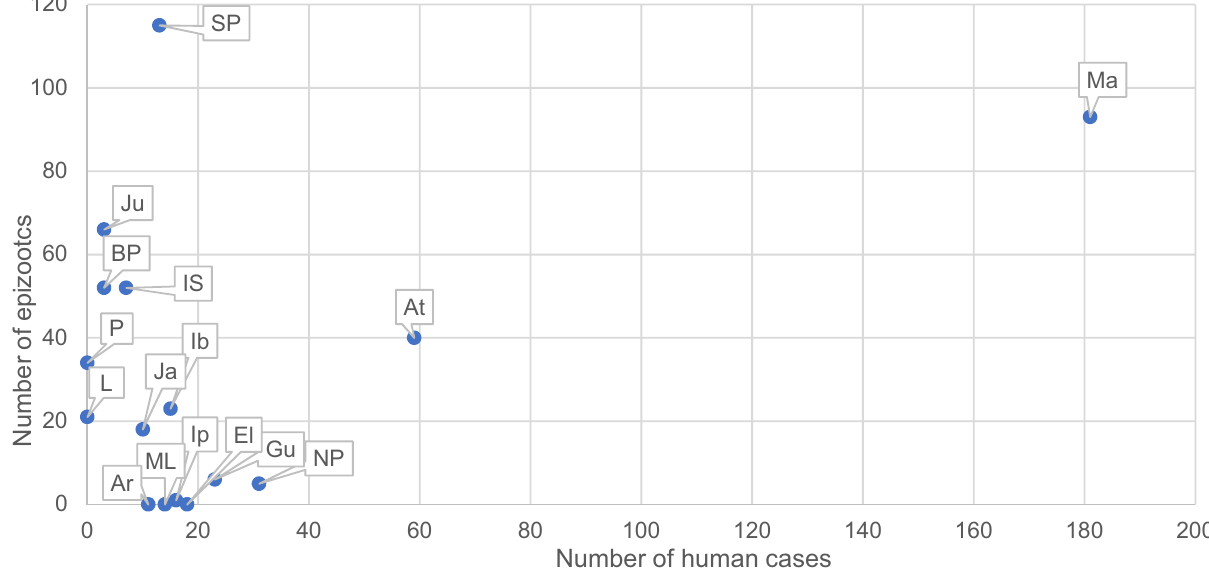
Figure 2. Ten municipalities of the state of São Paulo with more autochthonous human cases of yellow fever and ten with more epizootics between 2016 and 2019 ( Ma Mairiporã, At Atibaia, NP Nazaré Paulista,